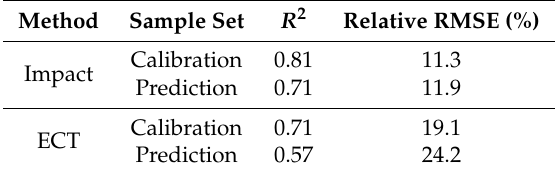
Figure 4. Linear regressions of the true and predicted sample moisture content based on wet mass flow rate ( M ) estimates from ( a ) the impact mass flow method and dry matter flow rate ( D ) estimated using ( b ) the ECT method. Table 2. Summary of root mean squared error for the two MC prediction